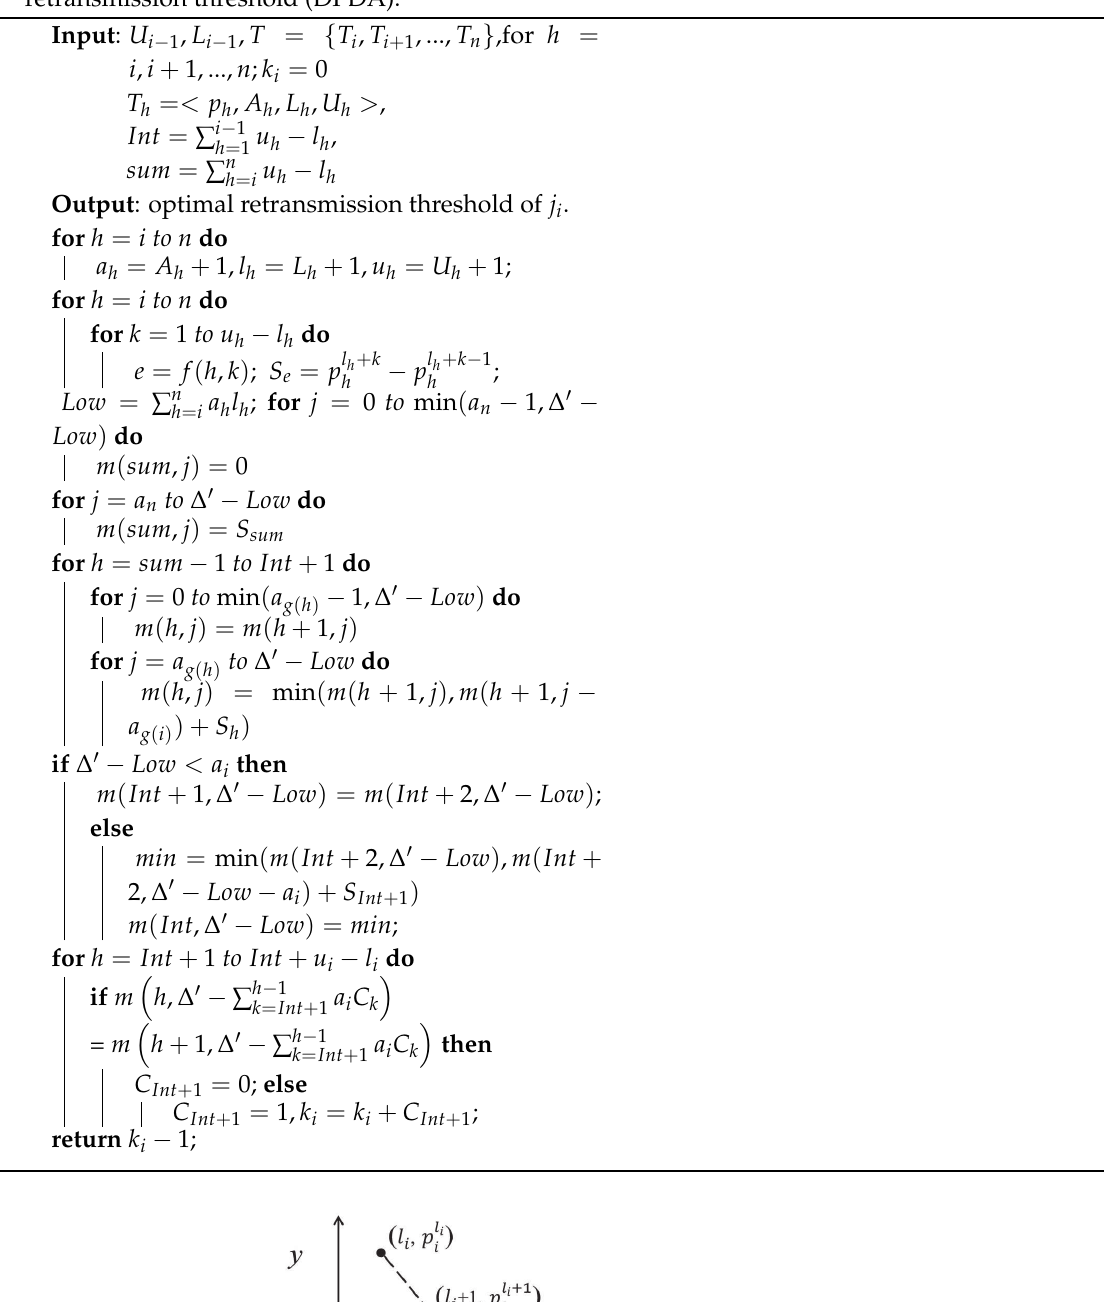
Algorithm 1: Dynamic Programming-based Distributed Algorithm for the optimal retransmission threshold (DPDA).